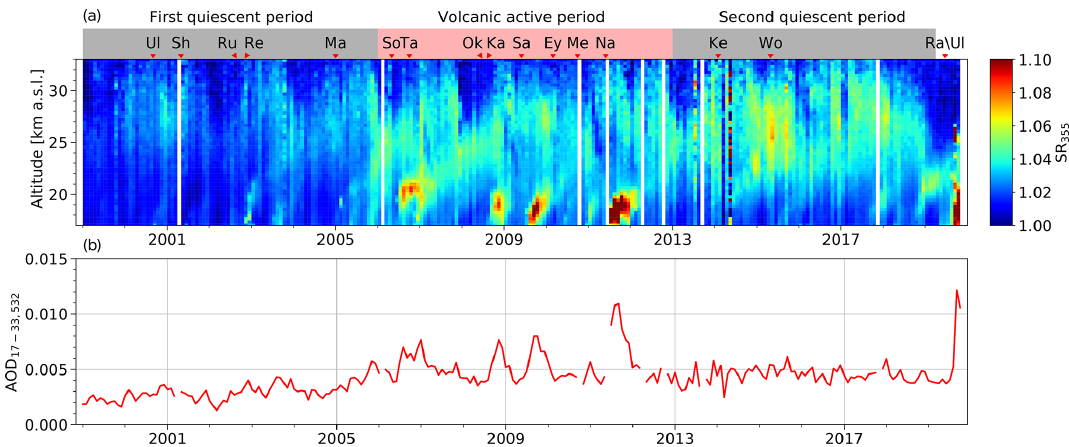
Figure 1. Monthly averaged time series of the stratospheric scattering ratio at 355nm retrieved from MLSOL between January 1999 and November 2019 (a) . Eruptions with a VEI ≥ 4 that occurred during this period are indicated at the top of the plot (see Table 1). Three different periods defined based on the impact of the volcanic activity are also shown (see text for details). Monthly averaged AOD retrieved from MLSOL extinction profiles (b) . Table 1. List of eruptions with VEI ≥ 4 in the tropics and Northern Hemisphere between January 1999 and November 2019. Information regarding the location of the erupting volcano and the maximum plume altitude (MPA) reported by the Global Volcanism Program is included for reference (https://volcano.si.edu/, last access: 10 May 2020). The Raikoke eruption is included in the list, although the VEI has not been determined yet. NA – not available. Volcano Eruption